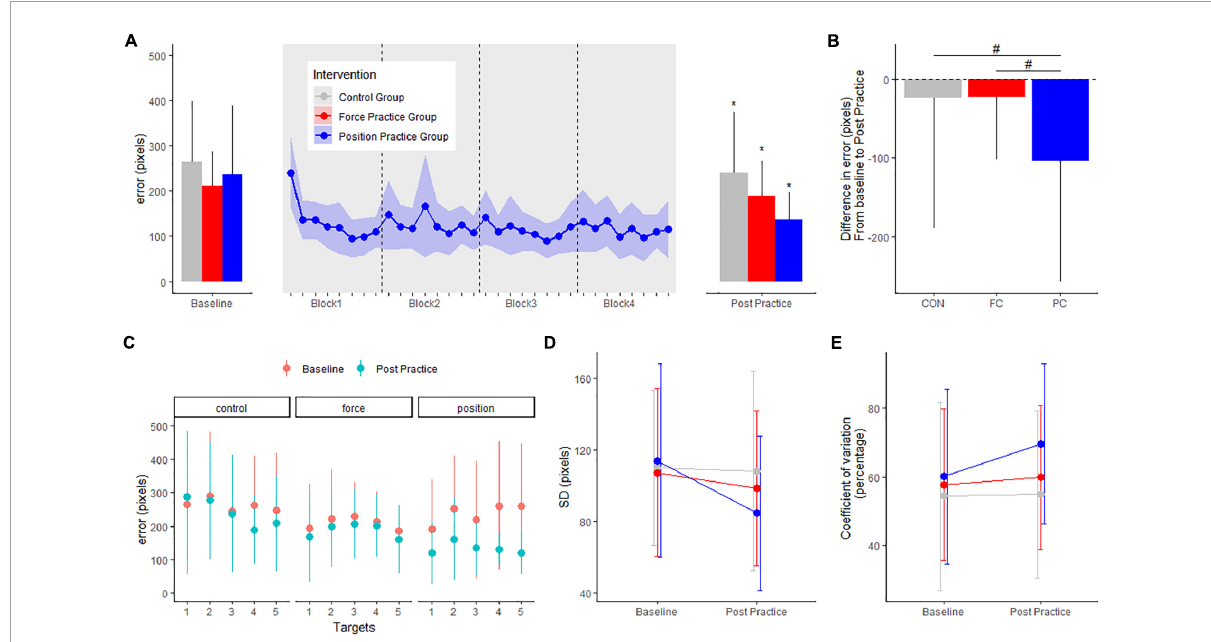
FIGURE2 Mean errors (pixels) at baseline and post practice conditions from in the position control task in the three groups in the main experiment are depicted in panel (A) : the position control practice group (blue), force control practice group (red) and control group (gray). Learning curves from the four blocks of position control practice is shown in panel (A) . The delta changes (error) in the position control task are shown in panel (B) . Target specific mean errors (pixels) in the position control task at baseline and post practice in the three groups are shown in panel (C) . Standard deviations from mean error in the three groups are shown in panel (D) while coefficient of variation in percentage are shown in panel (E) . *Denotes a significant difference within group and # denotes significant difference between